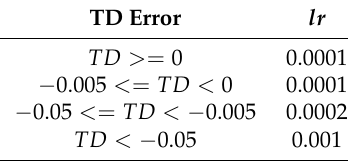
Table 3. Comparison of optimal return values obtained by different learning rates.